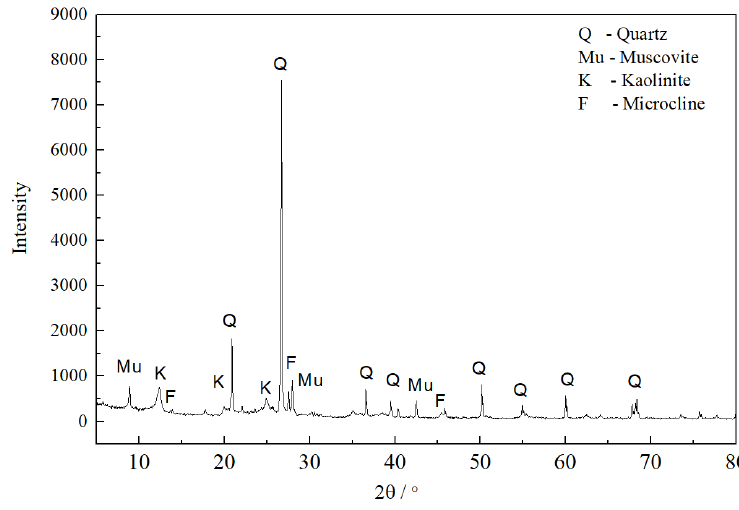
Figure 1. XRD pattern of the raw material. Table 3. Chemical composition (wt%) of R and M.